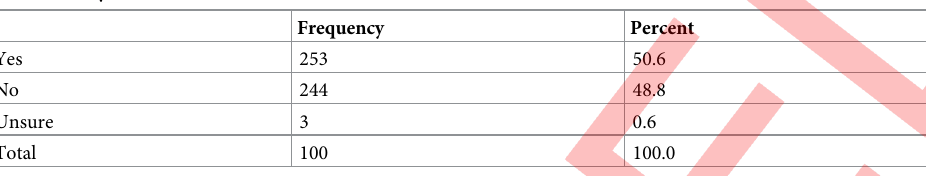
Table 2. Do you have malaria fever before?